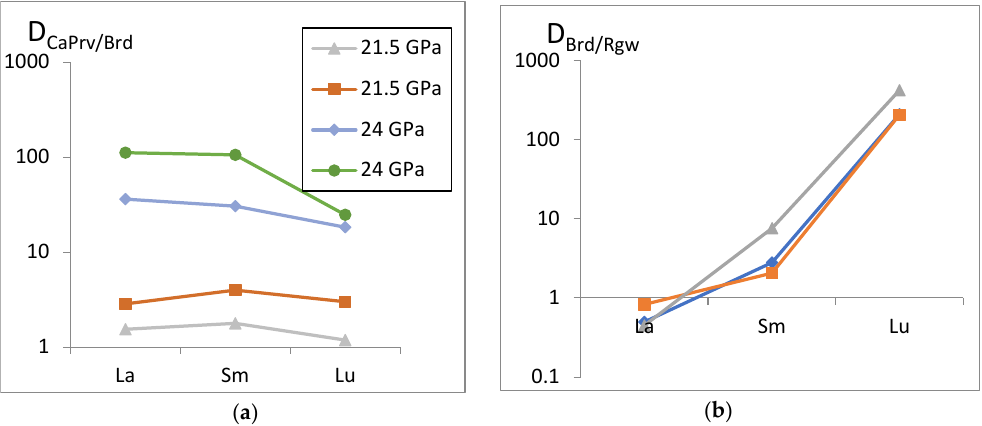
Figure 2. ( a ) Change in the CaSiO 3 perovskite/bridgmanite REE partition coefficients with pressure in the system diopside-3REE. Samples 3224-1 and 3214-2; ( b ) REE partition coefficients for bridgmanite and ringwoodite in the system ringwoodite-3REE showing the positive slope from La to Lu. Sample 3224-1, the pressure is 24 GPa; the temperature for all samples is 1600 °C. Table 2. Concentrations of trace elements and measurement errors in synthetic phases (ppm, La-ICP- MS analyses) as compared with some natural [18] and experimental [19] data.